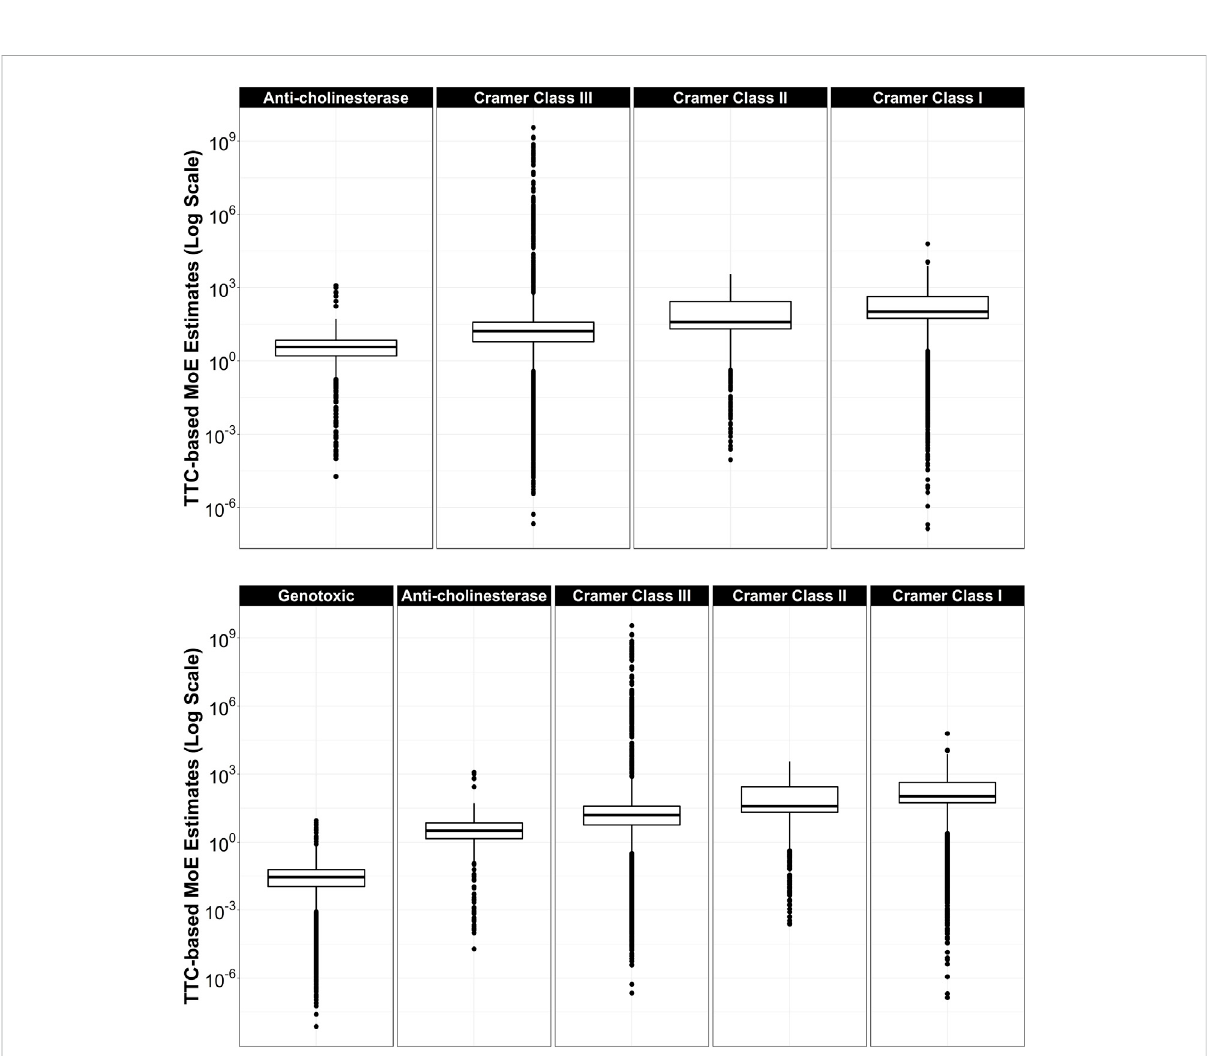
FIGURE 3 Top: TTC-based Margins of Exposure by TTC category. From left to right: Anti-cholinesterase ( n = 1506), Cramer Class III ( n = 35,772), Cramer Class II ( n = 1346), Cramer Class I ( n = 6391), for compounds that have both TTC and ExpoCast SEEM exposure estimates. Dots above each box and whiskerrepresentchemicalswithMoEsoutsidethe5thand95thpercentoftherange.Bottom:Sameastop,butwithGenotoxic( n =11,407)category